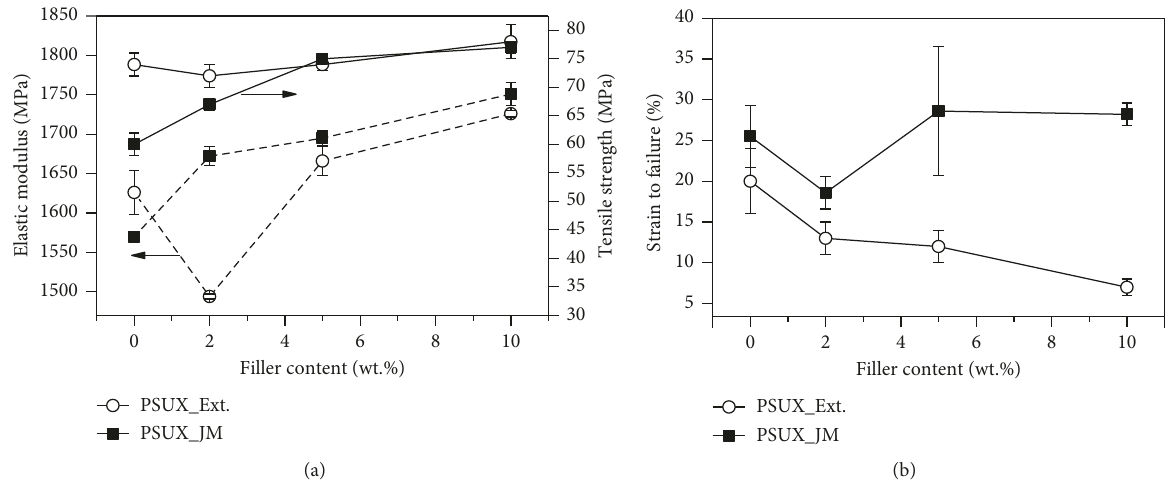
Figure 6: (a) Elastic modulus (dashed lines), tensile strength (solid lines), and (b) strain to failure as a function of filler content for PSU/ alumina processed by extrusion ( ○ ) and jet milling ( ■